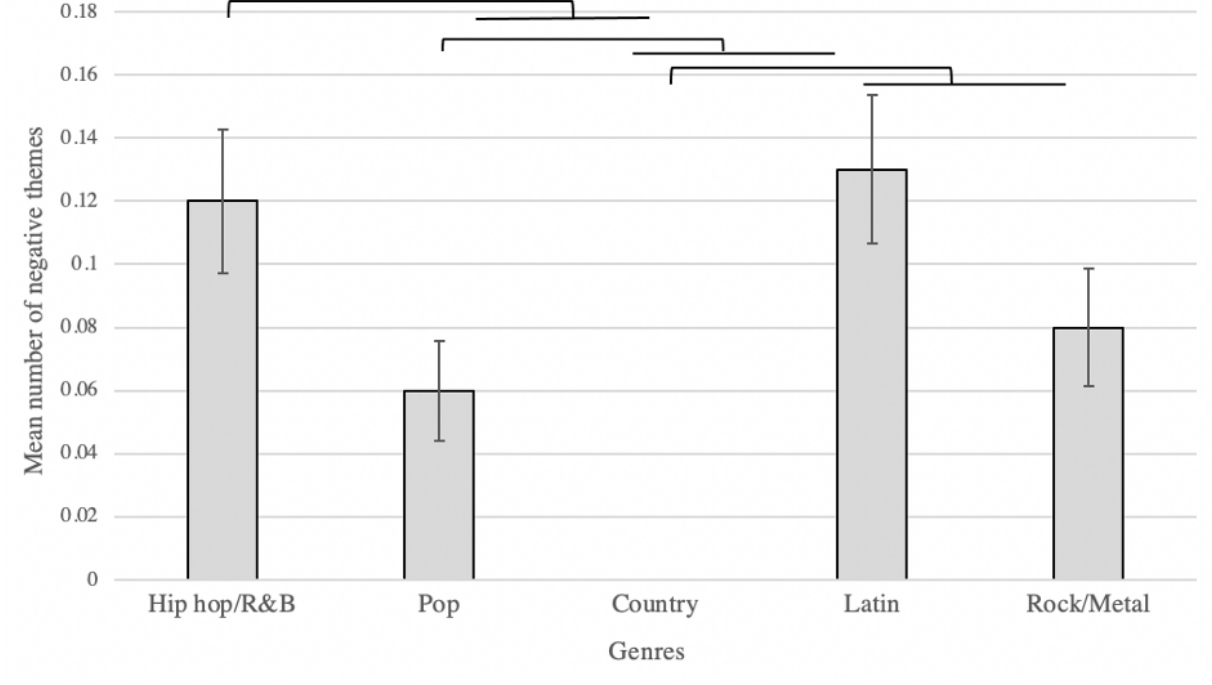
Figure 3. Mean number of negative themes in each genre from 1998 to 2018. Error bars reflect SE. Results show hip hop/R&B had a significantly higher number of negative themes in music videos when compared to pop ( P =.02) or country ( P <.001). Pop had a significantly higher number of negative themes when compared to country ( P <.001) or Latin music ( P =.01). Country had a significantly higher number of negative themes when compared to Latin music ( P <.001) and rock/metal ( P <.001). R&B: rhythm and